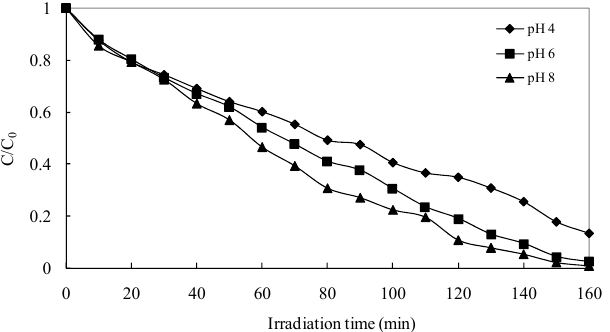
Figure 5. Effect of pH on the photocatalytic degradation rate of AO.